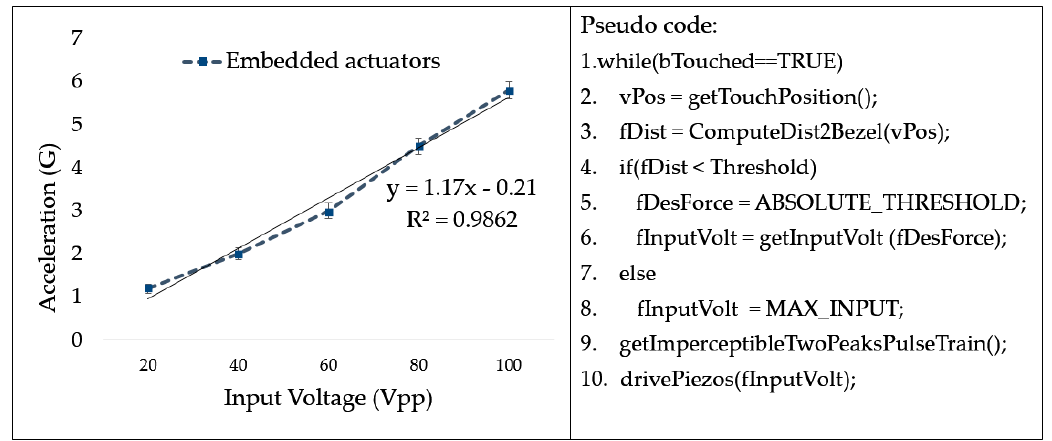
Figure 6. A proposed algorithm to equalize tactile key click effects on the table touchscreen; a linear regression function that has the best fit to the data points (embedded actuators) and a pseudo code that implements the key click equalization algorithm (right).